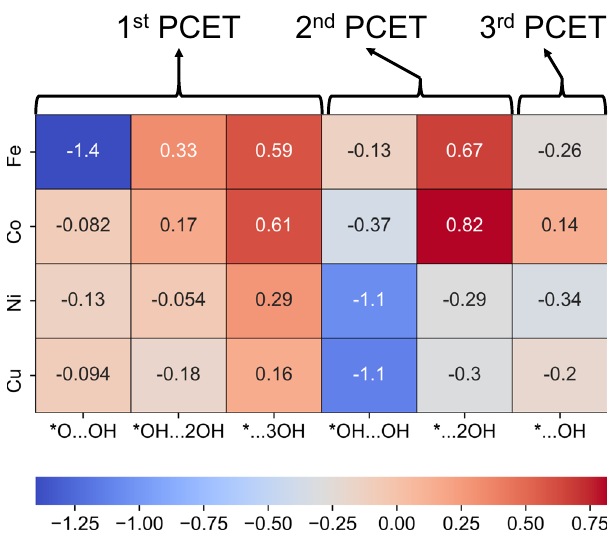
Fig. 2 Energy diagram of different reaction intermediates of different transition metal single atom catalyst to form pseudo-adsorption state of OH δ − . The heatmap shows the Δ E to form each pseudoadsorption state of OH δ − . The fi rst PCET step shows the dissociation of *OOH species and the further protonation steps of *O … OH δ − species. Second PCET step shows the protonation steps of *O species. Third PCET step shows the dissolution of *OH species into the solvent environment by the protonation from an adjacent water